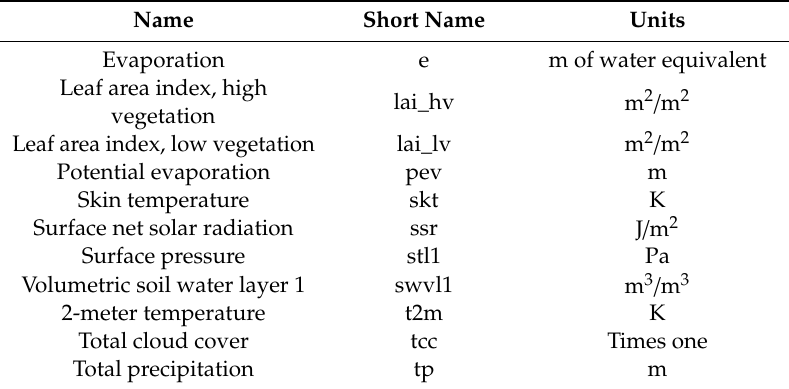
Table 1. Meteorological variables downloaded from ERA5 (ECMWF Re-Analysis) developed by the Copernicus Climate Change Service